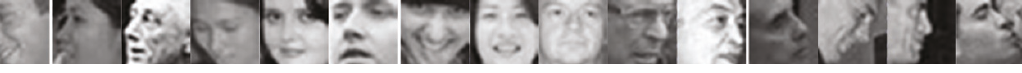
Figure 11: Some training samples.